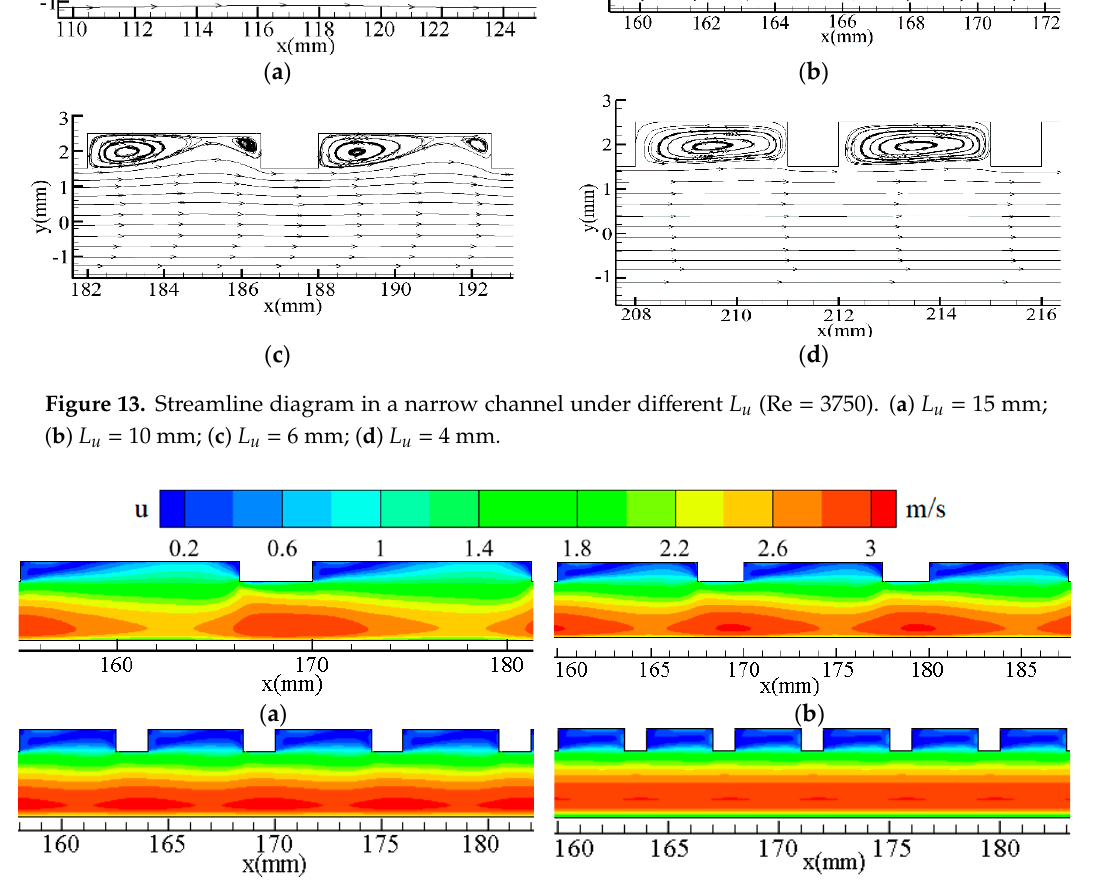
(Re = 3750). ( a ) = 15 mm; Figure 14. Contours of velocity in a narrow channel under di ff erent L = 3750). ( a ) L = 15 mm; u (Re u u L u L